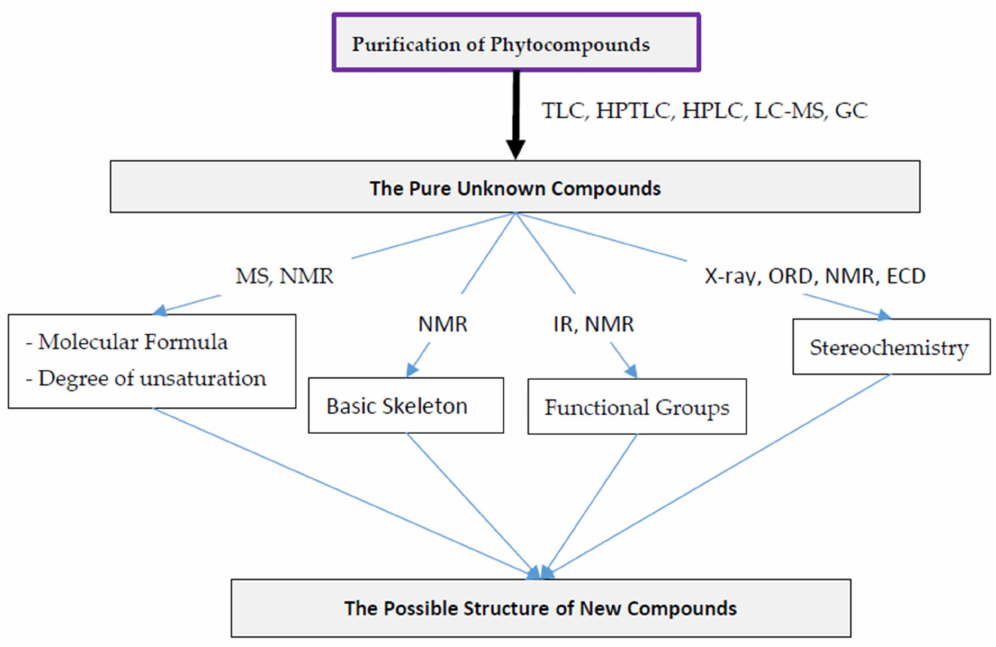
Figure 4. An outline for structural elucidation of new